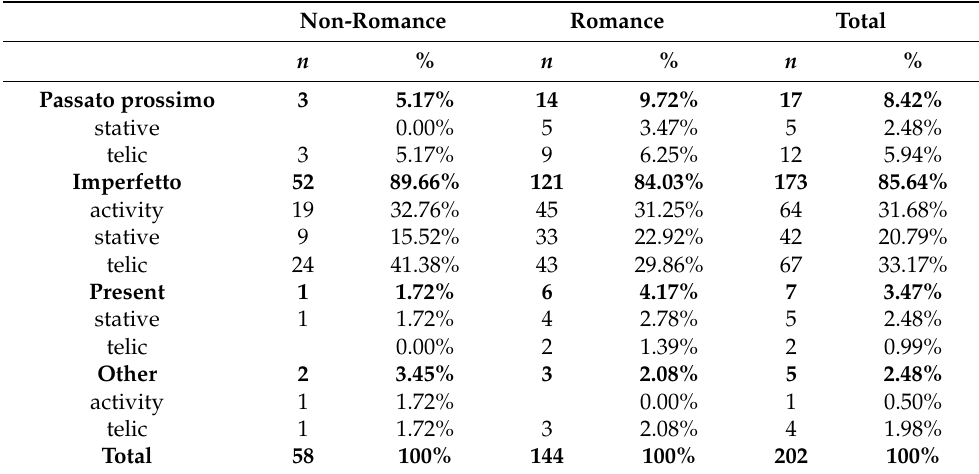
Table 7. Number of occurrences ( n ) and percentage (%) of tenses employed by high-proficiency learners in habitual contexts.